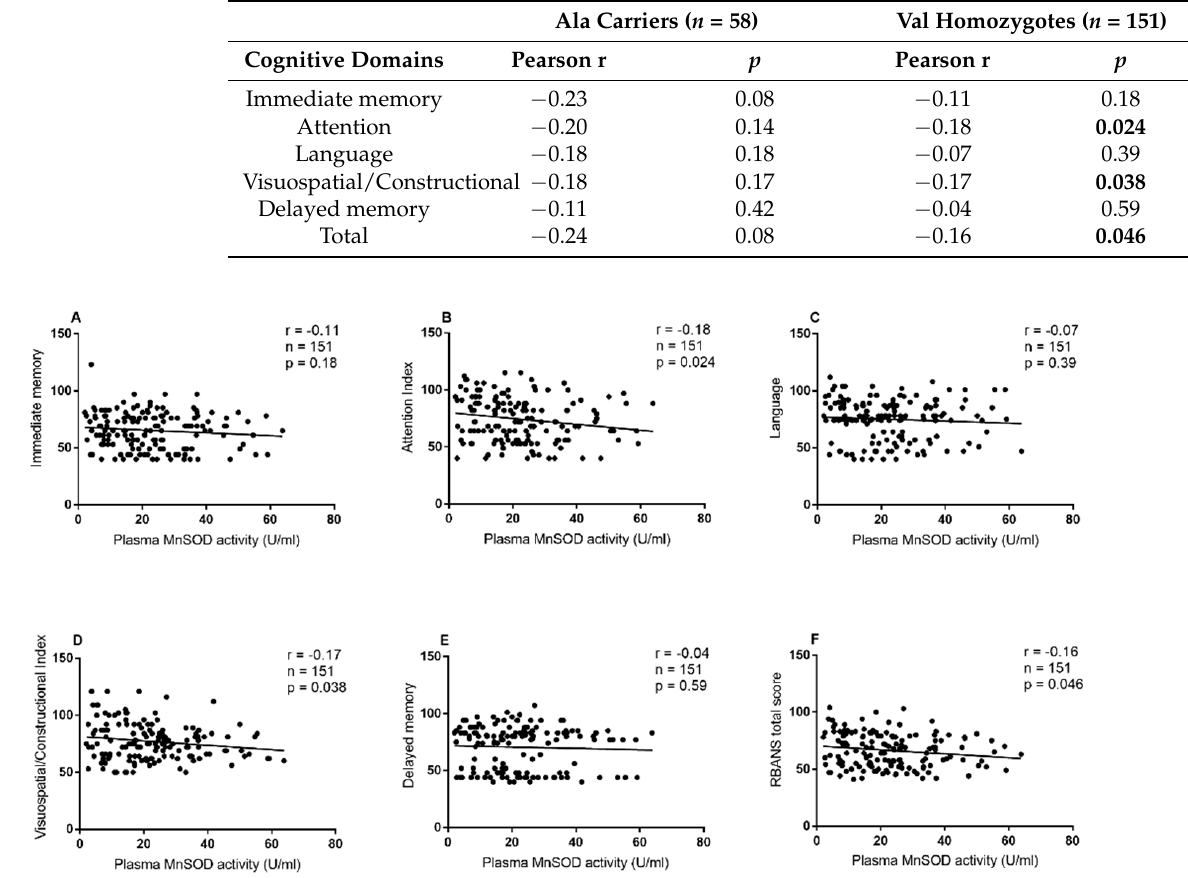
Figure 1. Association between MnSOD activity and cognitive performance in schizophrenia patients with the Val homozygote. Association between MnSOD activity and ( A ) Immediate memory, ( B ) Attention index, ( C ) Language, ( D ) Visuospatial/Constructional Index, ( E ) Delayed memory and ( F ) RBANS total score in schizophrenia patients with the Val